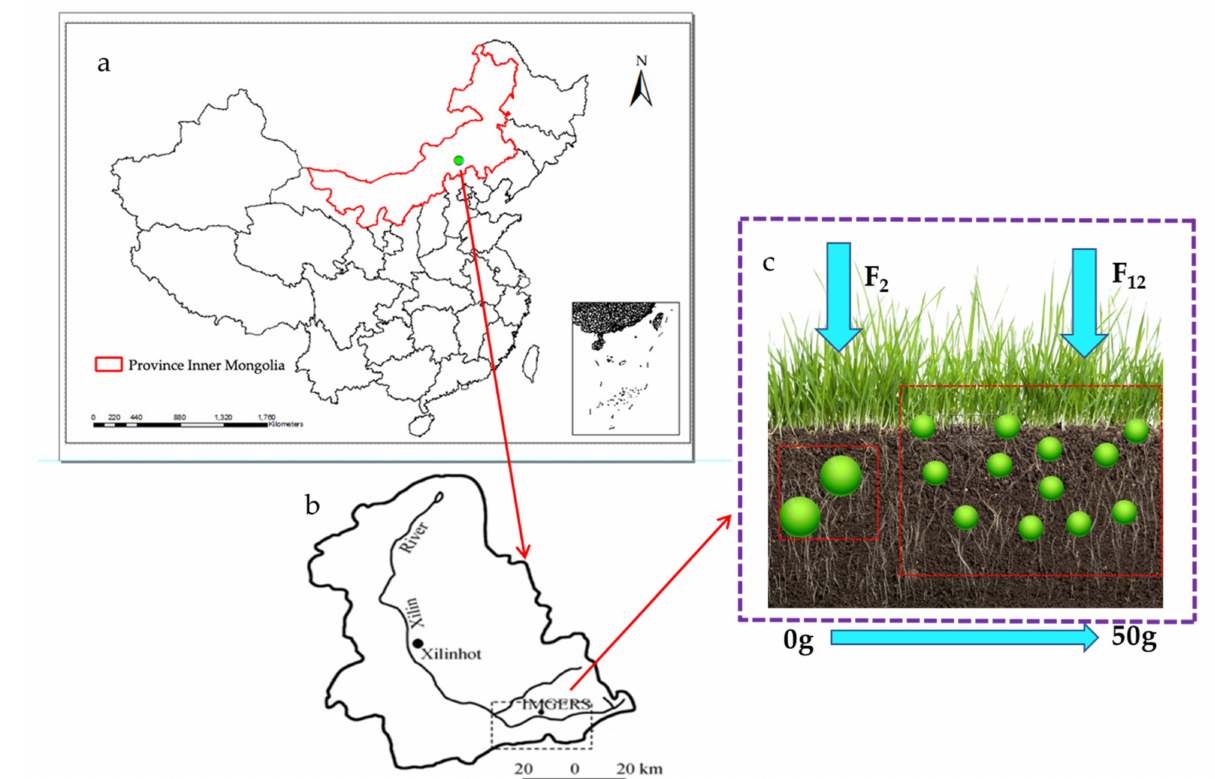
Figure 1. Experimental site ( a , b ) and experimental design ( c ), each plot was treated with one of five different N addition levels of N addition, i.e., 0, 2, 10, 20 and 50 g N m − 2 yr − 1 (designated as N-0, N-2, N-10, N-20 and N-50, respectively), at one of two addition frequencies of N (twice a year (F 2 ) vs. monthly (F 12